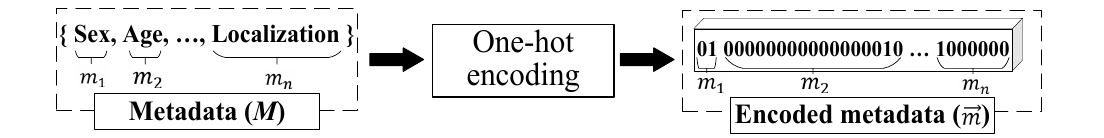
Figure 5. Metadata pre ‐ processing scheme.